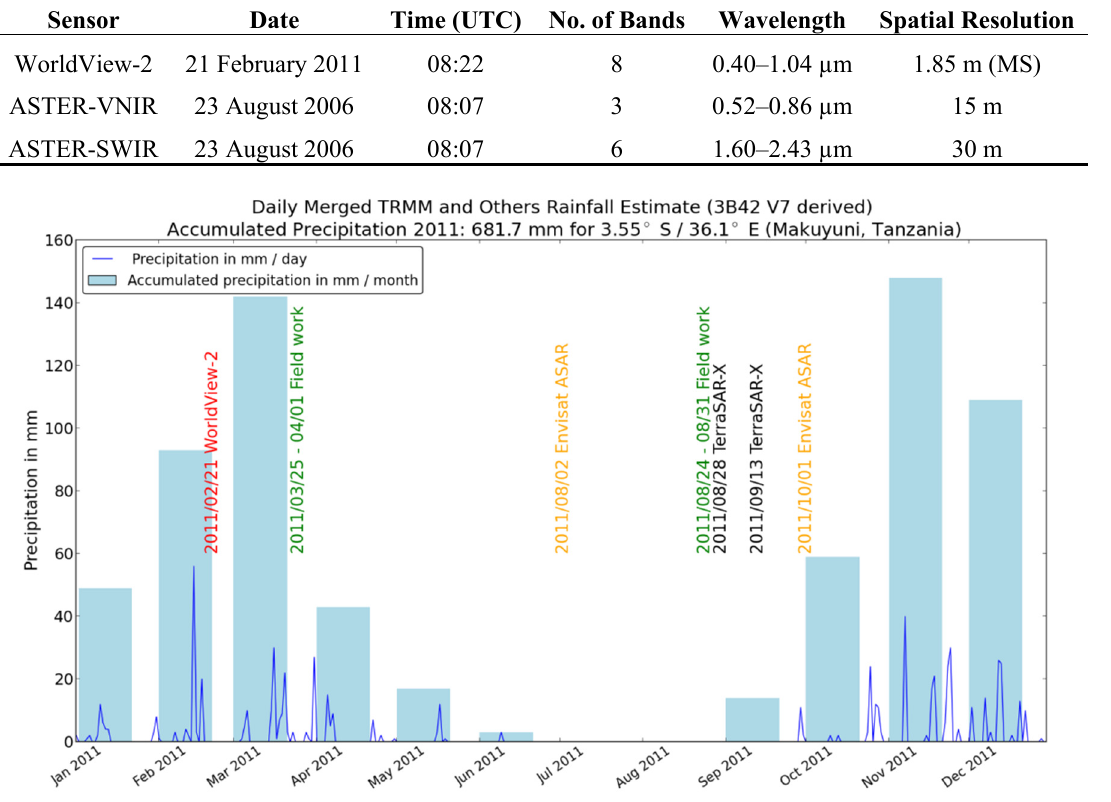
Figure 2. Precipitation, fieldwork and remote sensing data of the year